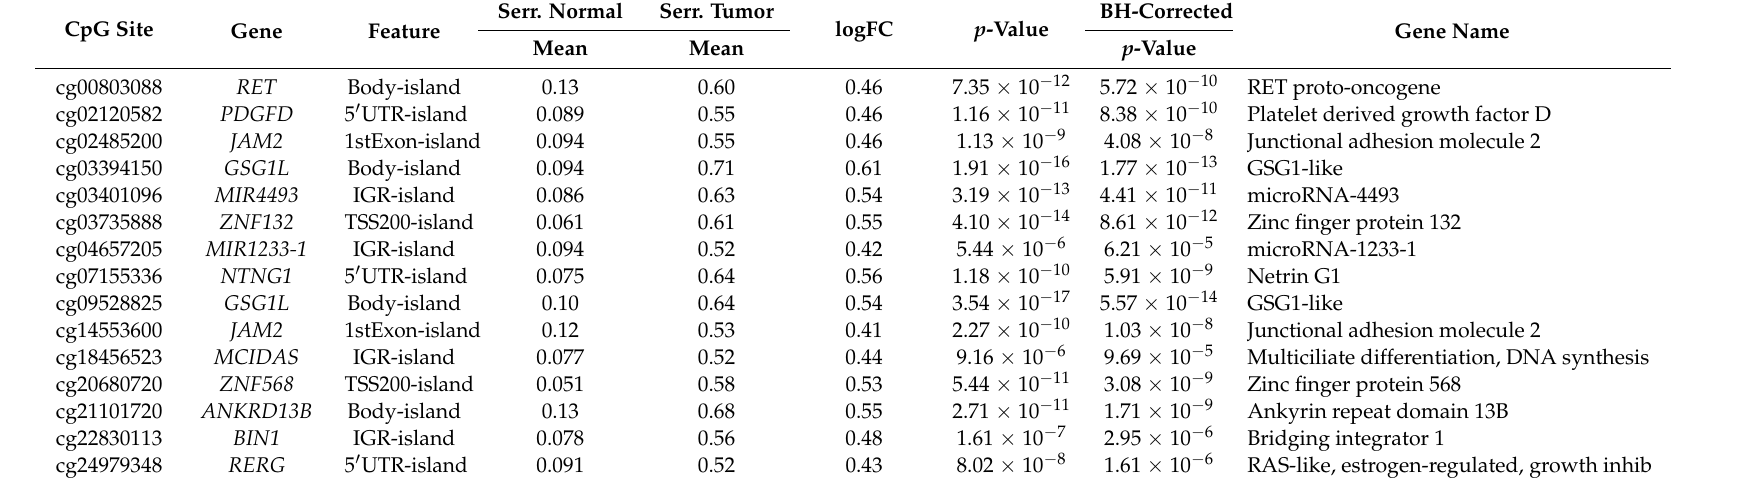
Table 2. Dysregulated CpG loci queried against Garcia-Solano et al. [15] serrated tumors vs. normal.